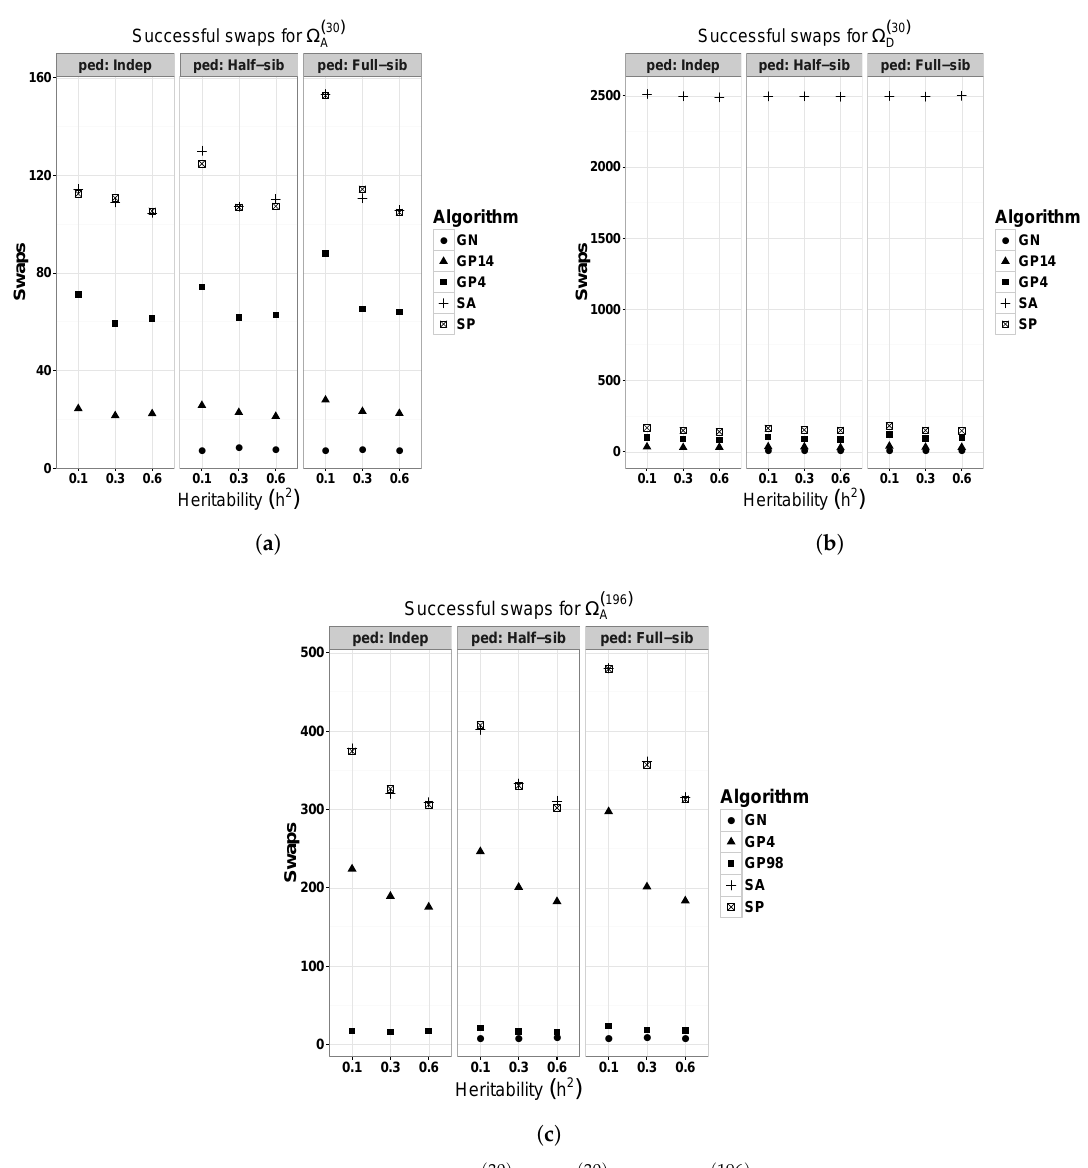
Figure 3. Average number of swaps for ( a ) Ω pairwise (SP), greedy pairwise: GP4, GP14, GP98, simulated annealing (SA) and genetic neighborhood (GN) algorithms iterated p = 5000 times, with each condition replicated λ = 10 times, with m = 100 initially unimproved